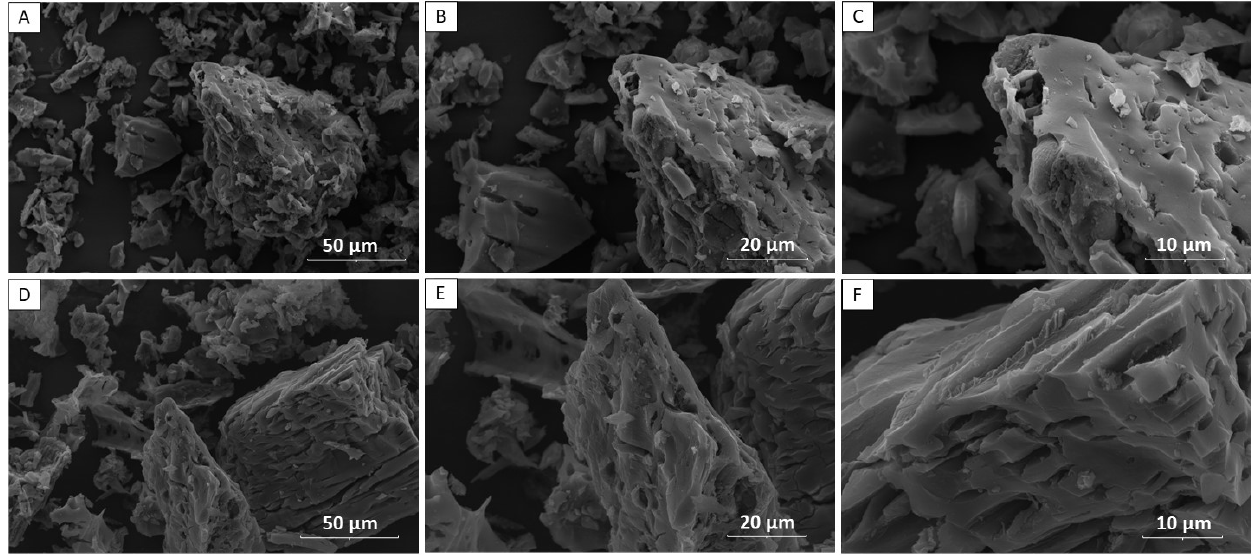
Figure 2. SEM images for the biochar (BE) sample with a size of 50 μm ( A ), 20 μm ( B ), and 20 μm ( C ), and for a sample of biochar (ABE) with a size of 50 μm ( D ), 20 μm ( E ), and 20 μm ( F